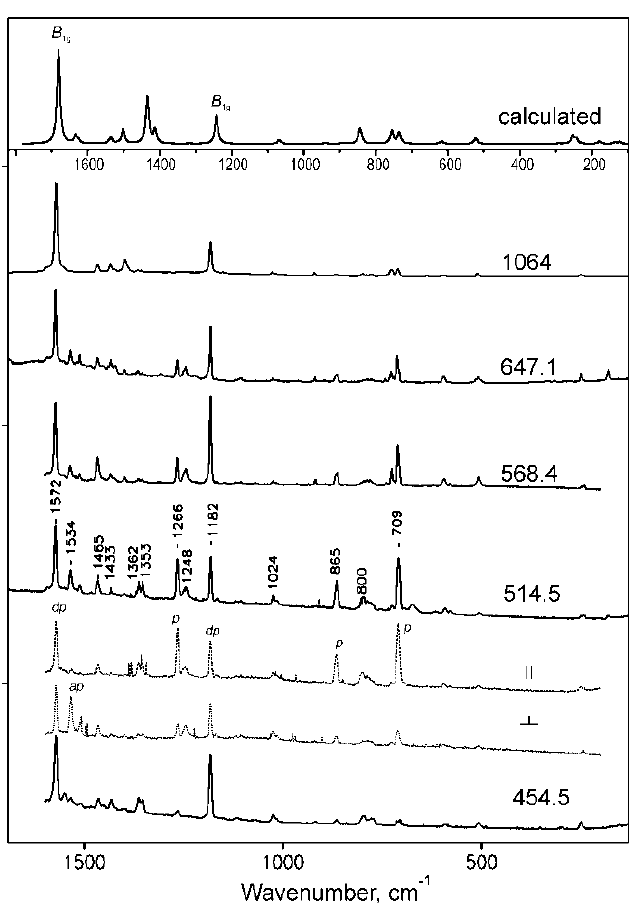
Figure 11. Resonance Raman spectra of NiTTDPz at different excitations (454.5, 514,5, 568.4, 647.1 and 1064 nm) and the theoretical spectrum representing Raman active vibrational modes. Polarized spectra are shown for 514.5 nm. Table 7. Assignment of the Raman vibrations of the H 2 TTDPz and NiTTDPz molecules.